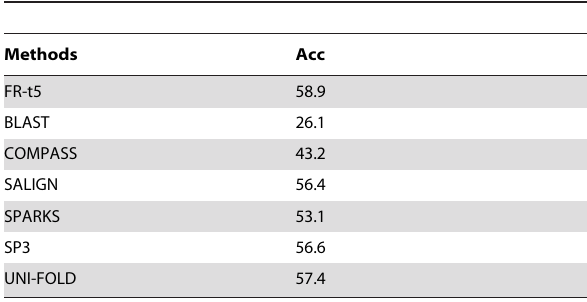
Table 4. The alignment accuracy (%) of FR-t5 on the SALIGN test data.